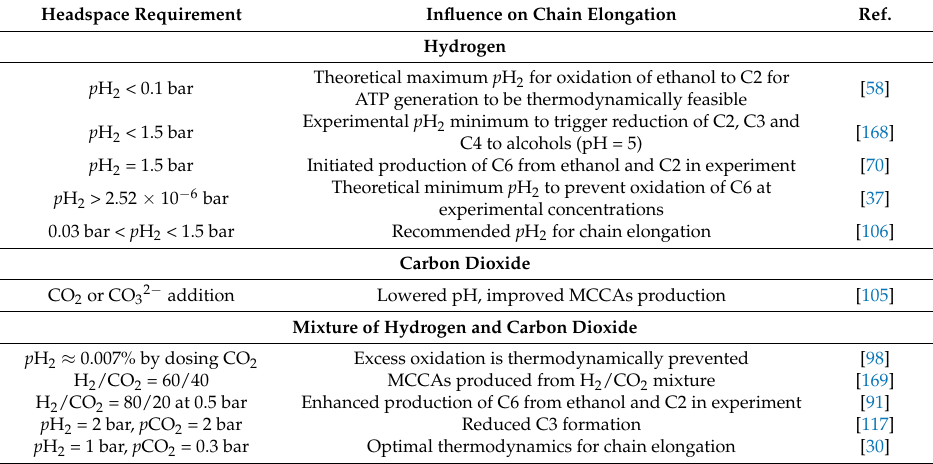
Table 5. Experimental and theoretical reported values of p H 2 and/or p CO 2 in reactor headspace to stimulate chain elongation in MMC